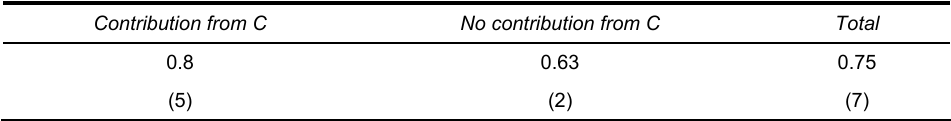
Table 8: Mean share of votes in favor of awarding the prize to the outgoing subject (position C) in periods where non-cooperative behavior has occured before period 4, by contribution from the outgoing player (N) Contribution from C No contribution from